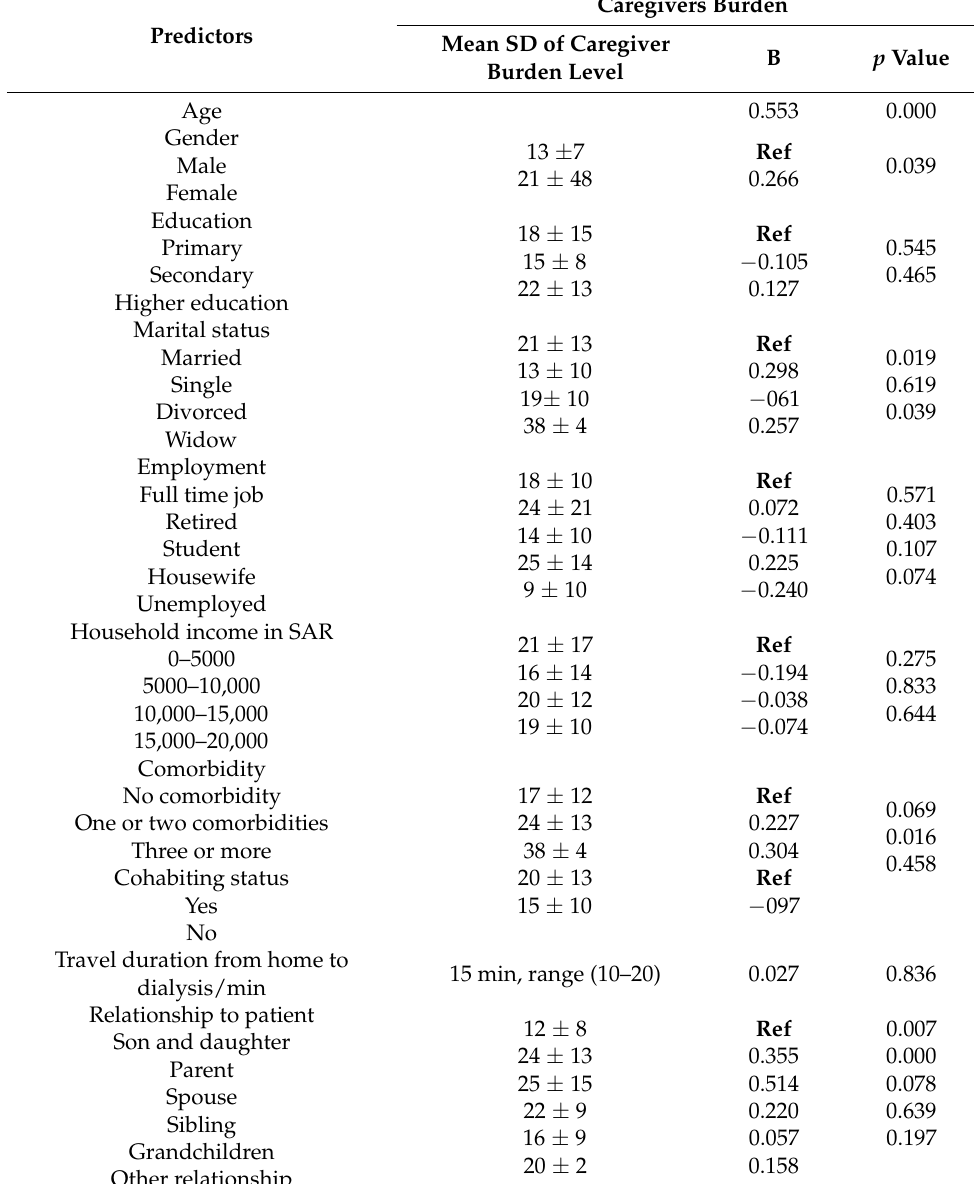
Table 3. Association between total caregiver burden and caregiver